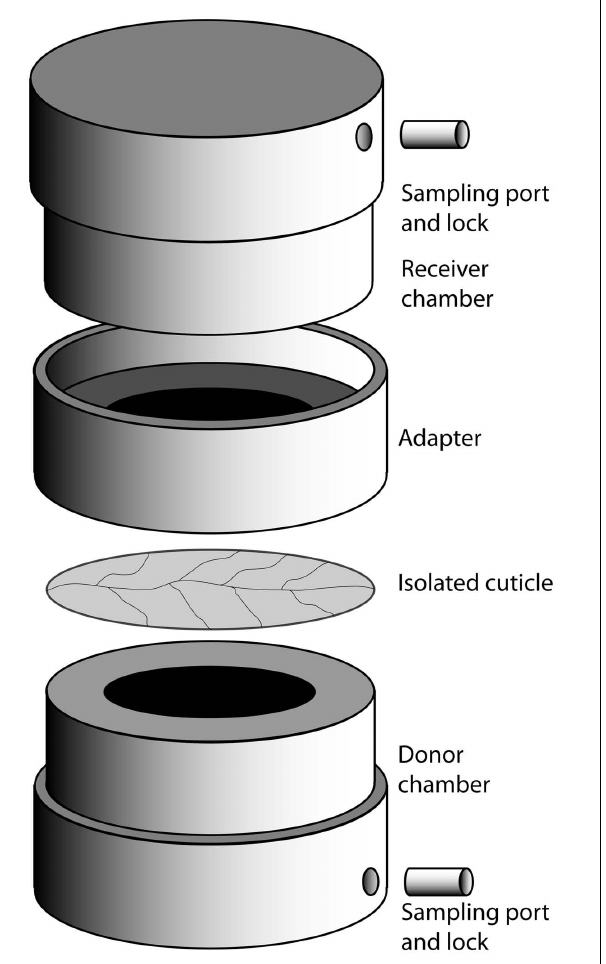
FIGURE 1 | Setup of the cuticle diffusion chamber. See [Measuring of fructose bulk flux by gas chromatography and flame ionization detection (GC–FID)] for